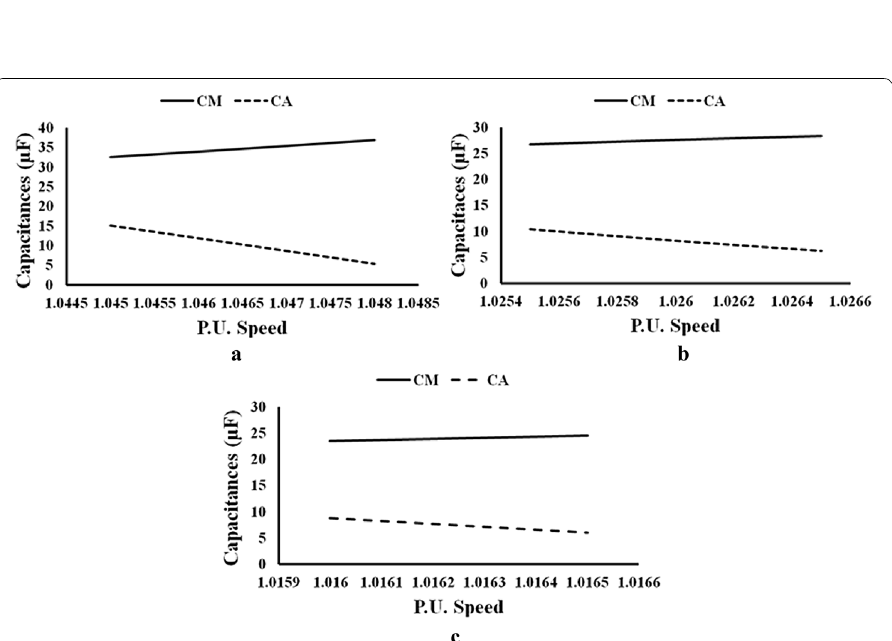
Fig. 8 a Main and auxiliary capacitance versus p.u. speed at a load of 140 Ω and 0.85 power factor, with constant load voltage and frequency, b Main and auxiliary capacitance versus p.u. speed at a load of 240 Ω and 0.75 power factor, with constant load voltage and frequency, c main and auxiliary capacitance versus P.U. speed at a load of 370 Ω and 0.65 power factor, with constant load voltage and